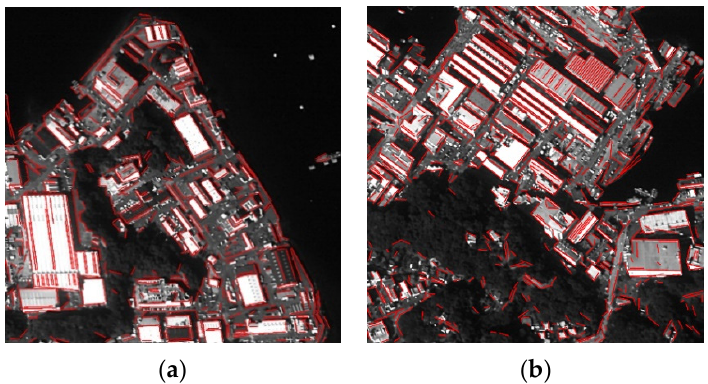
Figure 3. Line segment detection results. ( a ) Image I, ( b ) Image II.